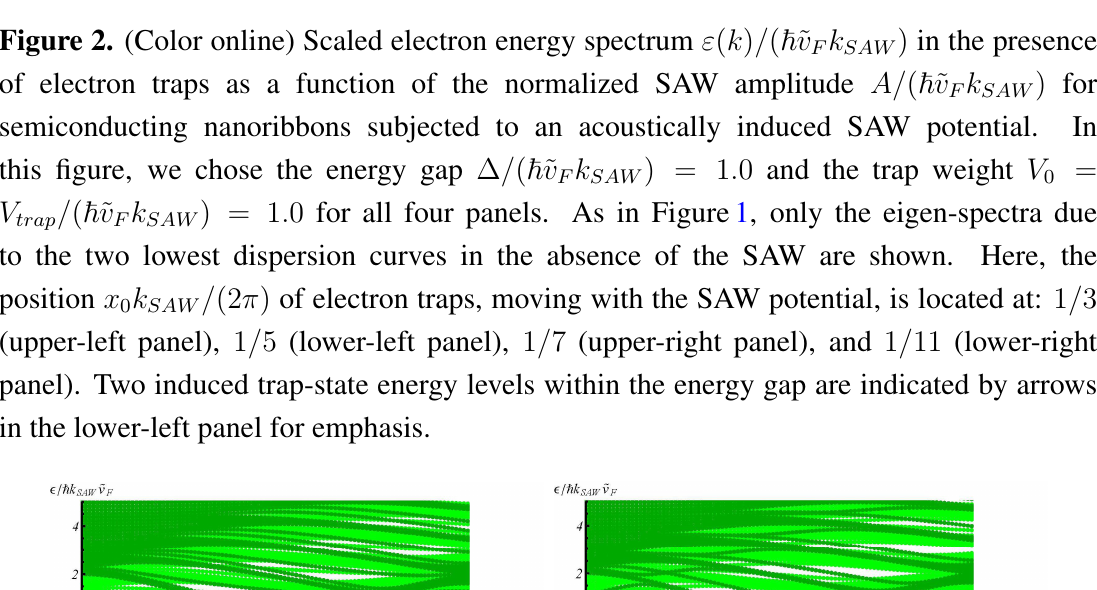
k ) in the presence F SAW k ) for F SAW k ) = 1 . 0 and the trap weight V = F SAW 0